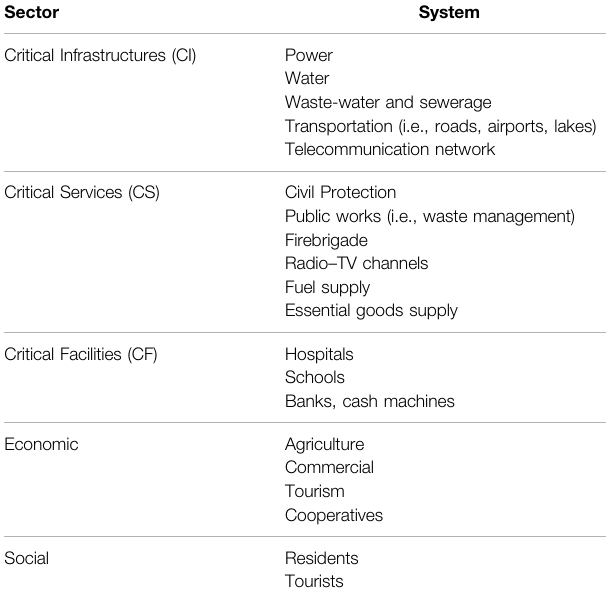
TABLE 2 | Sectors and systems analyzed in this study.